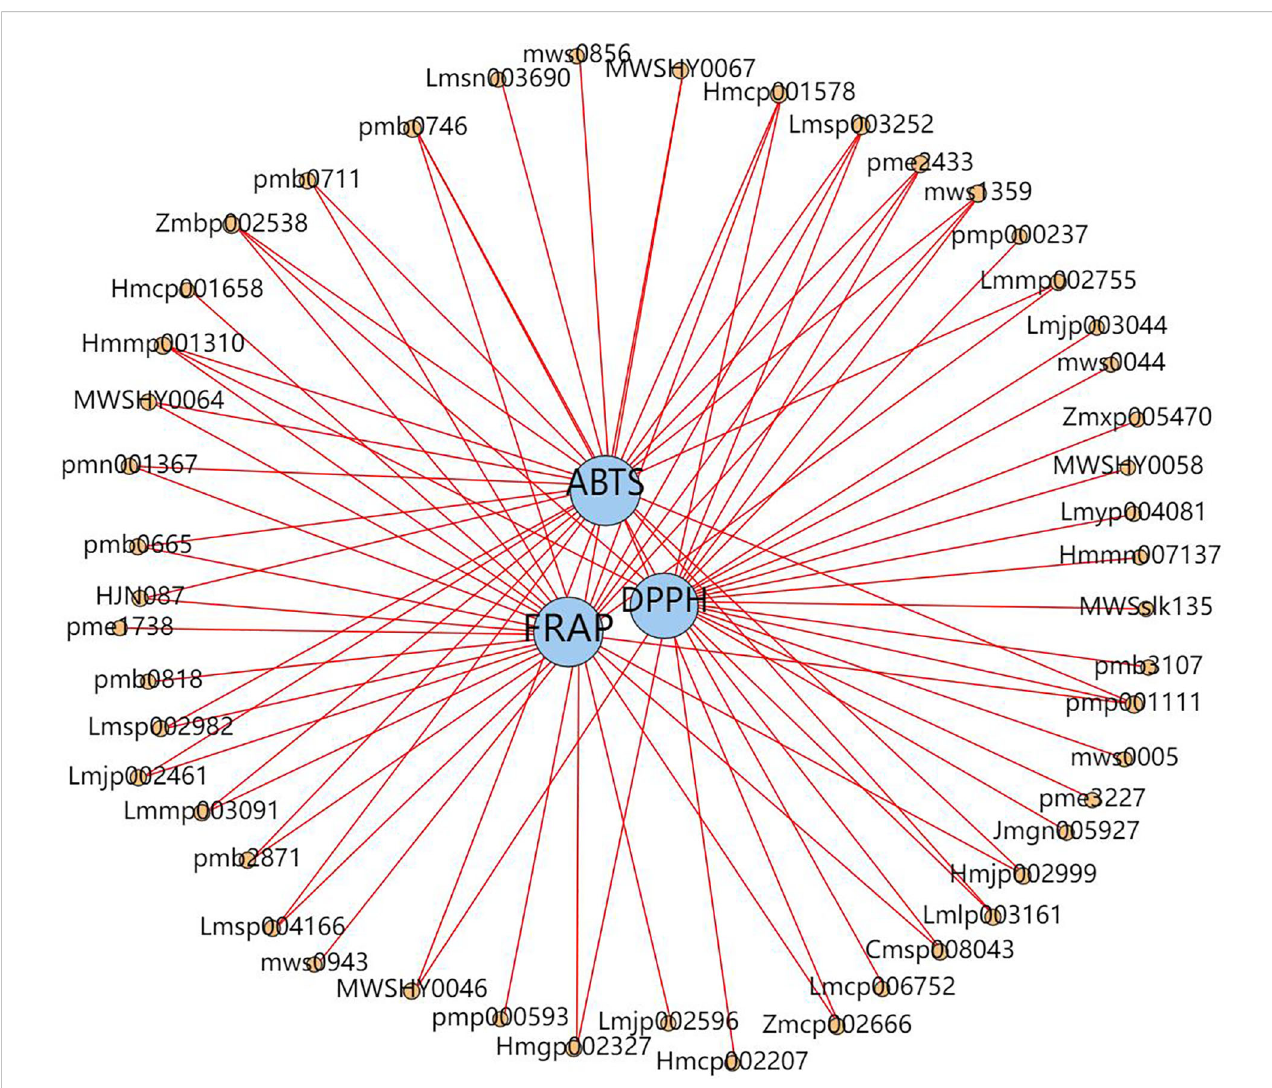
FIGURE 7 Network diagram between antioxidant capacity and metabolites. Blue circles indicate different antioxidant capacity (DPPH, 2,2-diphenyl-1-picrylhydrazyl radical scavenging ability; ABTS, 2,2 ’ -Azinobis- (3-ethylbenzthiazoline-6-sulphonate; FRAP, ferric reducing antioxidant power.), orange circles indicate different metabolites (The number above the circle indicates the component ID of Metware), and the line connecting the two circles represents the correlation (r ≥ 0.8, p <